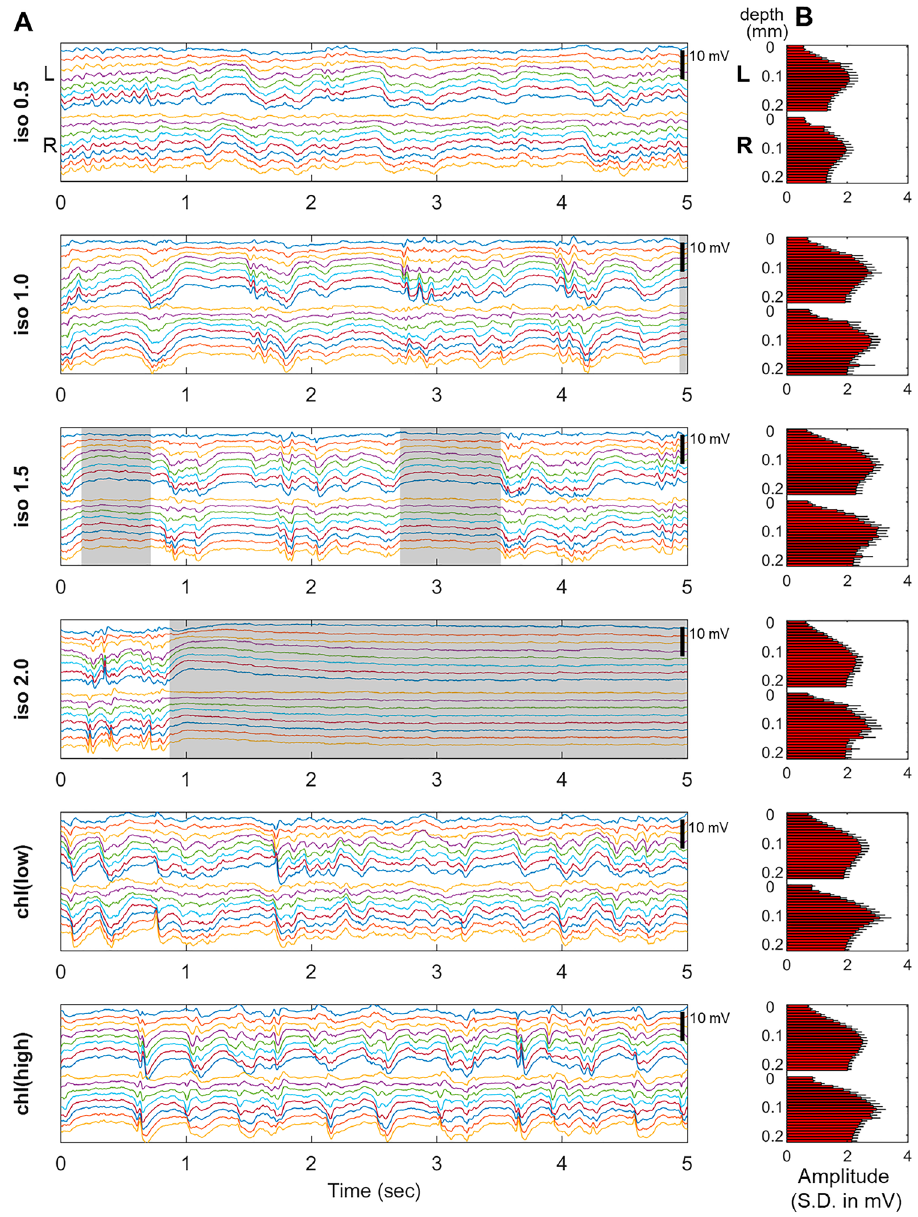
Figure 1. Spontaneous LFP activity across different anesthesia conditions for left (L) and right (R) S1fl. ( A ) An example of LFP recordings from a representative animal using a pair of laminar electrodes (every three channels are shown, i.e. depth of 0.1, 0.4, 0.7, 1.0, 1.3, 1.6, 1.9 and 2.2 mm). Shaded areas indicate suppression periods. ( B ) The amplitudes of spontaneous LFP fluctuations (Standard deviation in spontaneous LFP activity, in mV) along the cortical depth. Group mean ± S.E. (n =